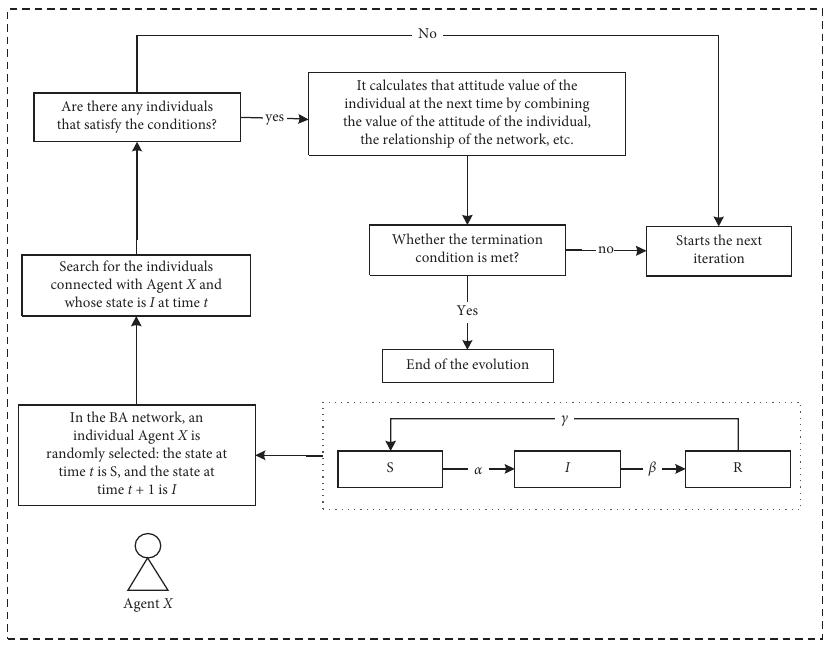
Figure 2: Public opinion polarization model in group behavior.